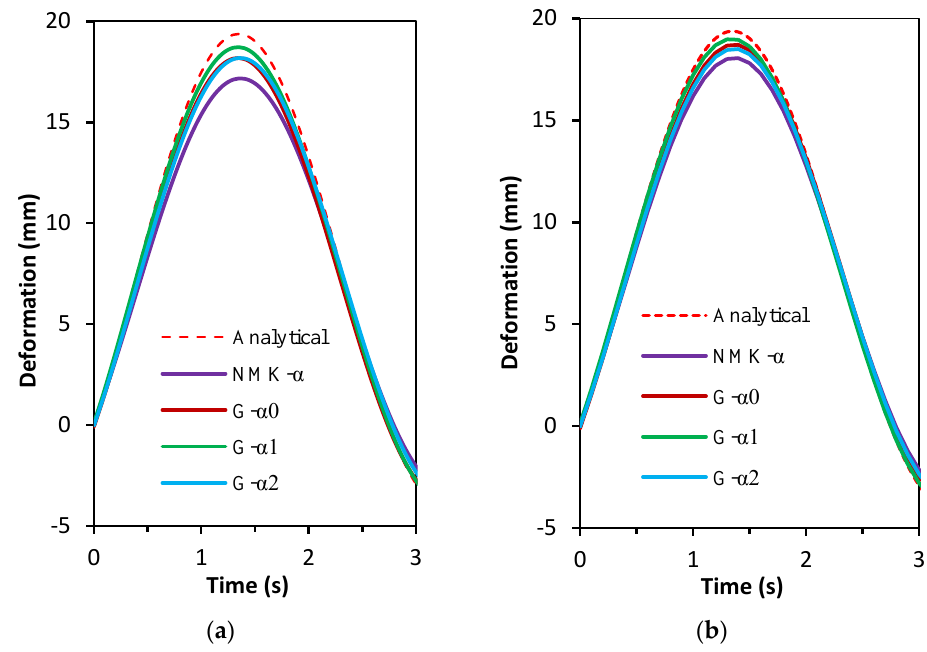
Figure 9. Simulated results of the first crest of deformation: ( a ) ∆𝑡 = 0.01 s; ( b ) ∆𝑡 = 0.001 s.